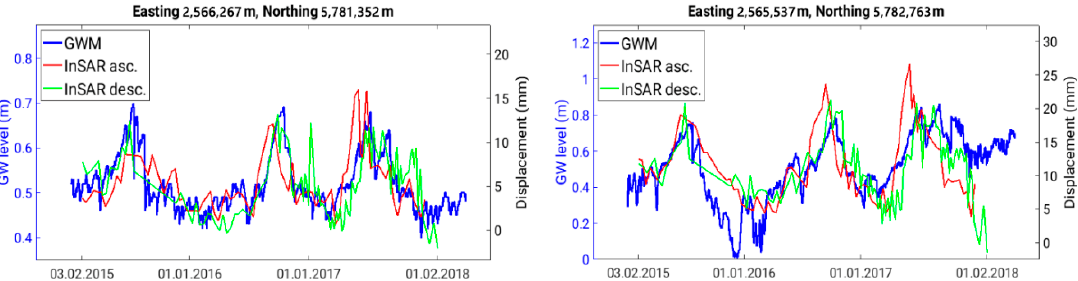
Figure 7. Examples of ground water levels together with scaled mean over InSAR time series of nearby points from each orbit.